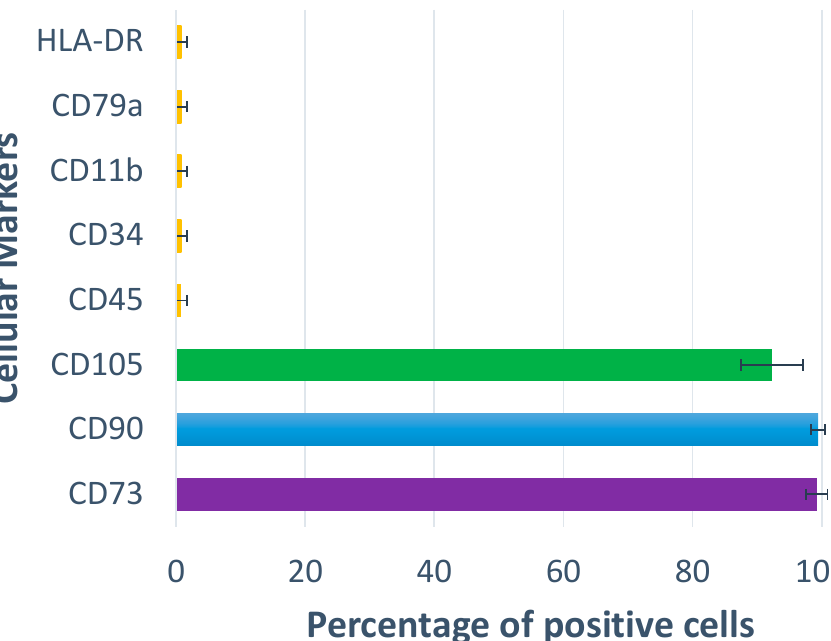
Figure 1. The phenotype of Mesenchymal Stem Cells used in the study. ( n = 12).